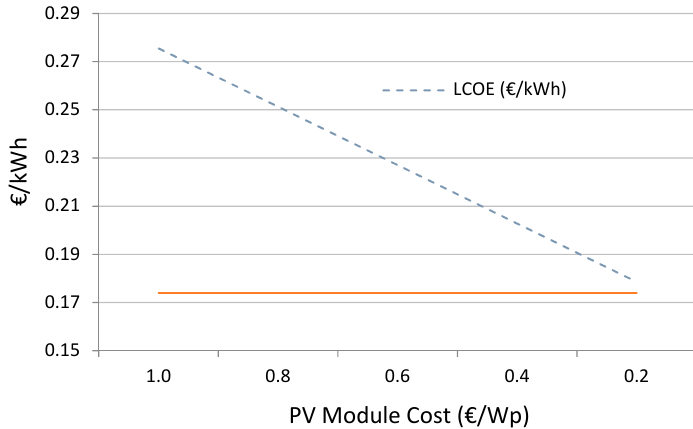
Figure 4. Analysis of the levelised cost of energy (LCOE) against the retail electricity cost at a fixed interest rate of 10% (5000 W inverter, deterministic method).